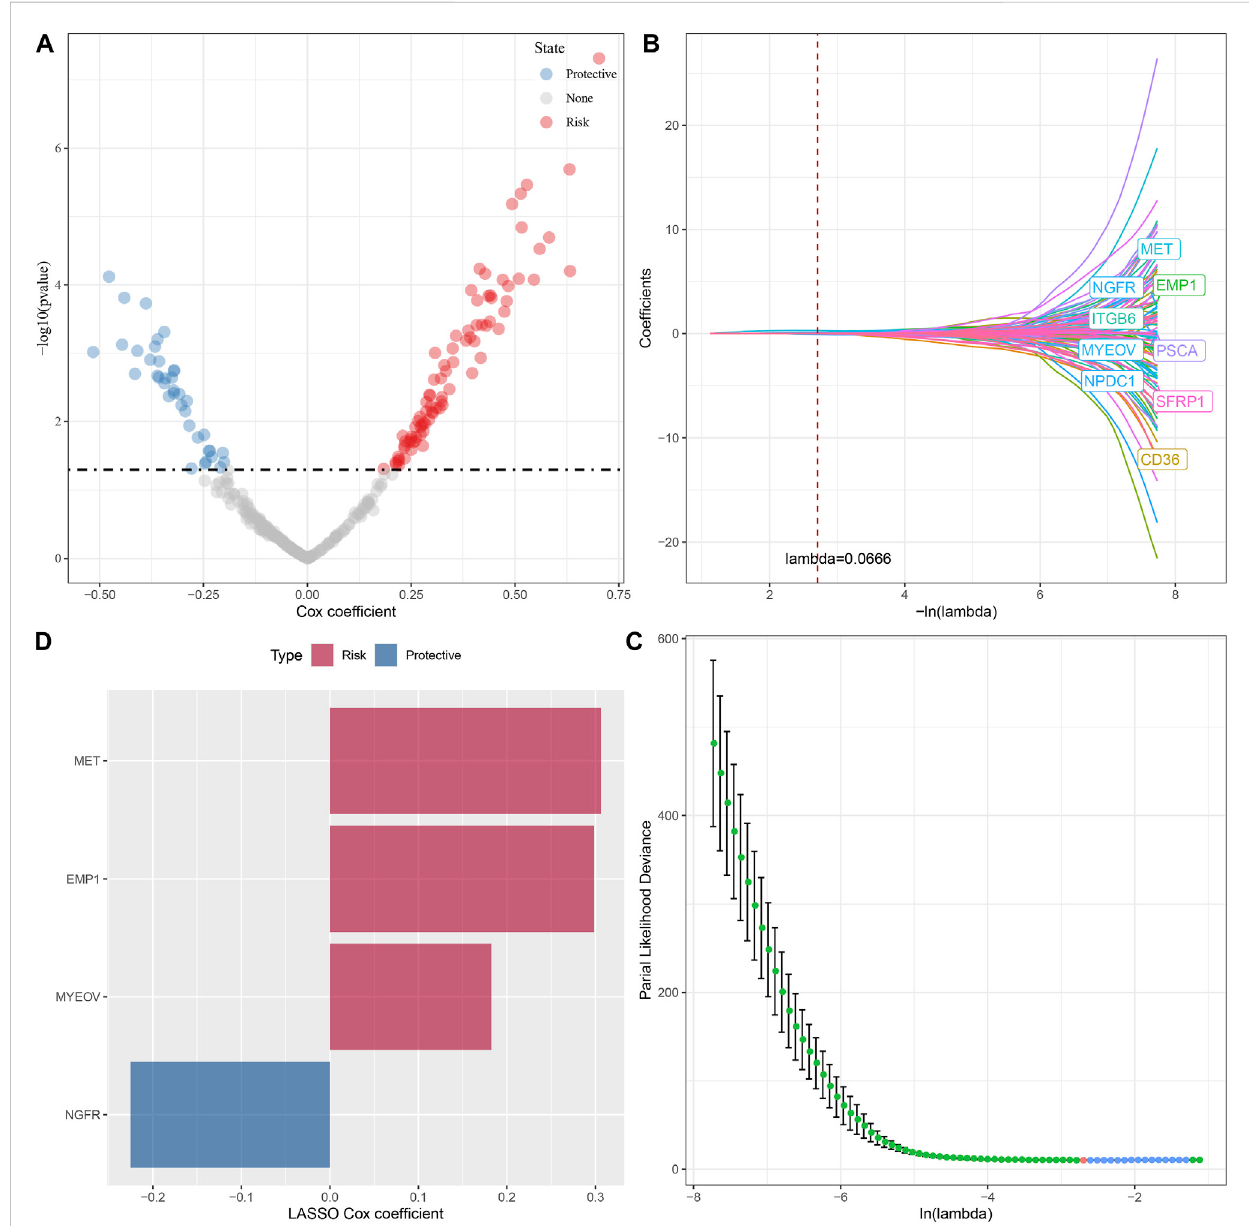
FIGURE 7 The identi fi cation of hub genes for the construction of the prognosis model, (A) A total of 122 promising candidates were identi fi ed from the DEGs; (B) The trajectory of each independent variable with lambda; (C) Con fi dence interval under lambda; (D) Distribution of LASSO coef fi cients of the Natural Killer Cell-related prognostic gene